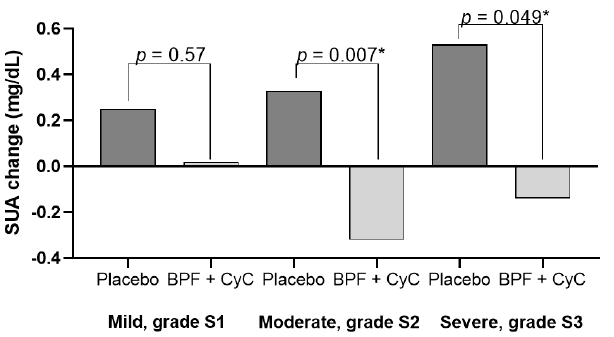
Figure 2. SUA change according to severity of hepatic steatosis at baseline. * Adjusted for age, gender,